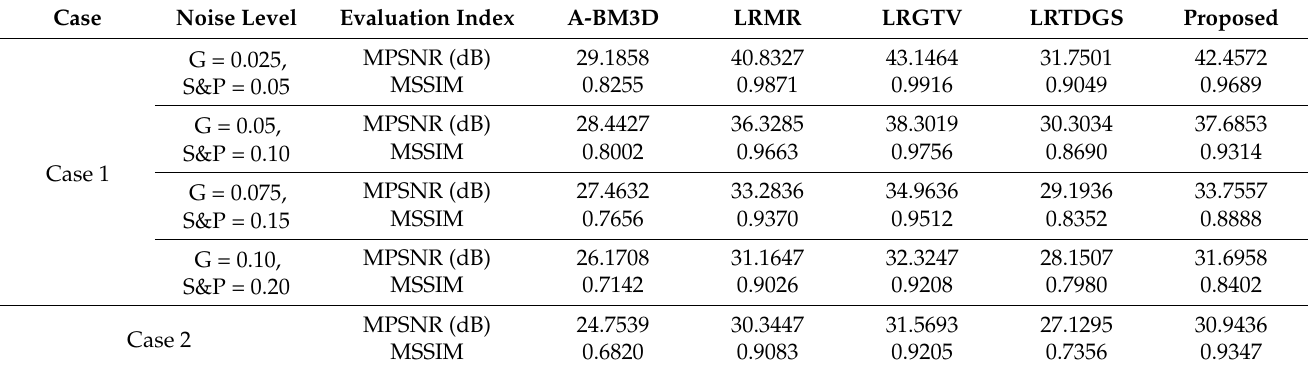
Table 3. Quantitative evaluation of the different methods on the Pavia